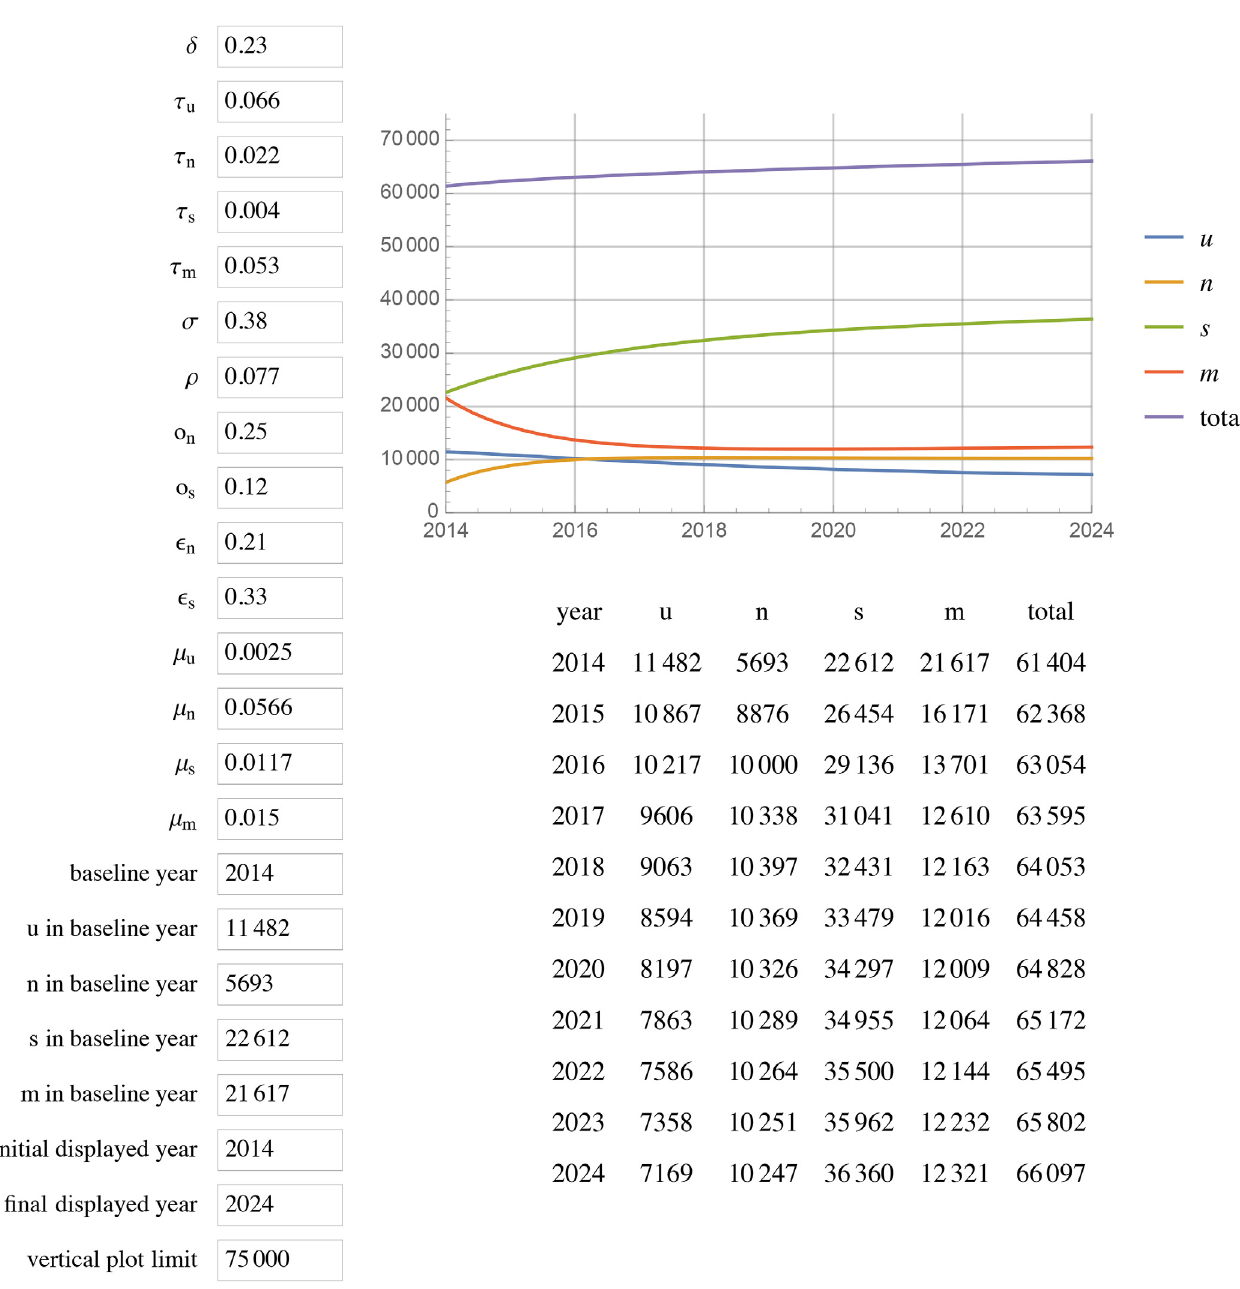
Fig 4. HIV prevalence projections with rates of (cid:2) n and (cid:2) s tripled. (cid:2) n represents the rate of re-entry in care but not VS. (cid:2) s represents the rate of r e- entry into care and achieving VS.